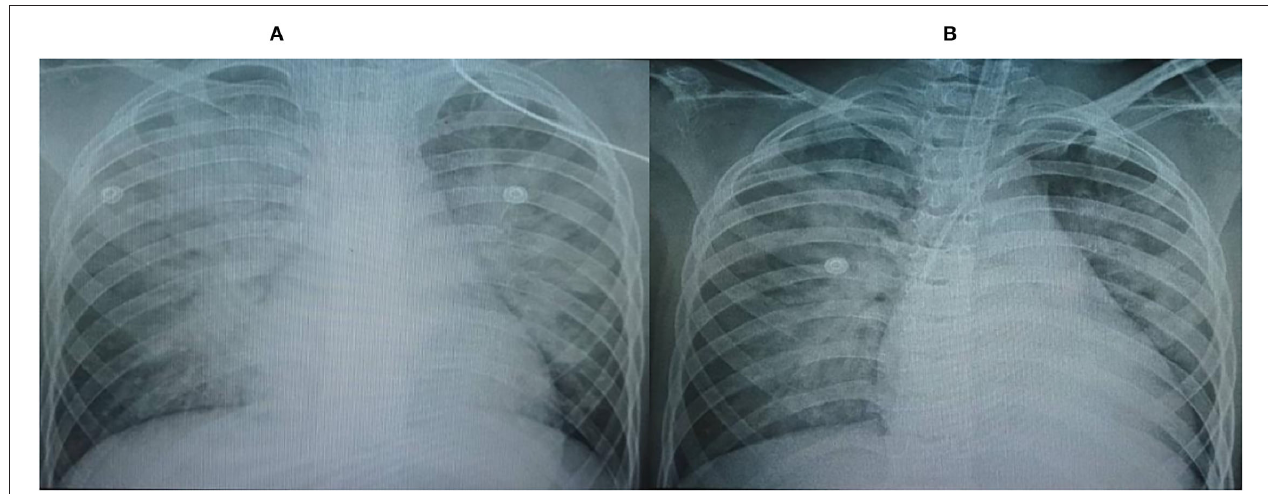
FIGURE 1 | Chest x-rays (CXRs) revealed pulmonary opacification of the bilateral perihilar region and cardiomegaly with a mildly increased cardiothoracic ratio. (A) On admission, (B) Post-24h hemofiltration.